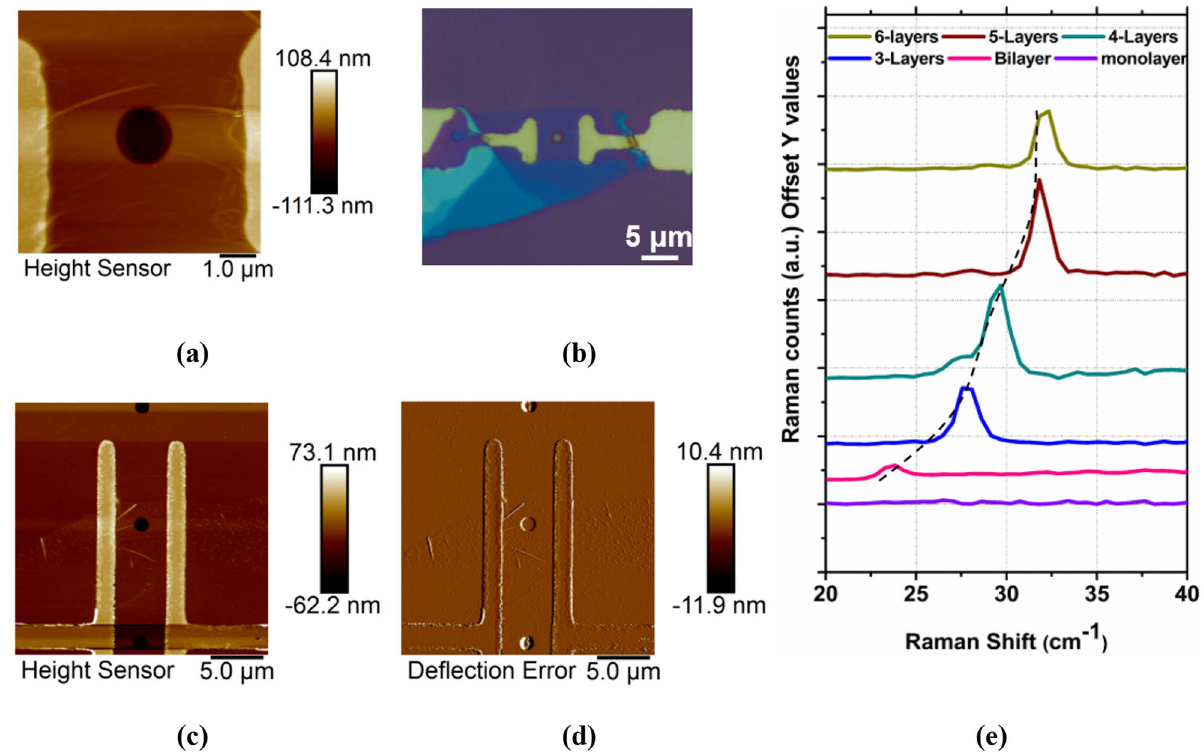
Figure 1. ( a ) AFM topography image of the suspended monolayer MoS 2 device-1. ( b ) Optical micrograph of device-1. ( c ), ( d ) AFM topography and deflection error image of device-2 (monolayer MoS 2 ) respectively showing that the flake is suspended on one of the circular trenches. ( e ) Low-frequency Raman modes of MoS 2 flakes with 1–6